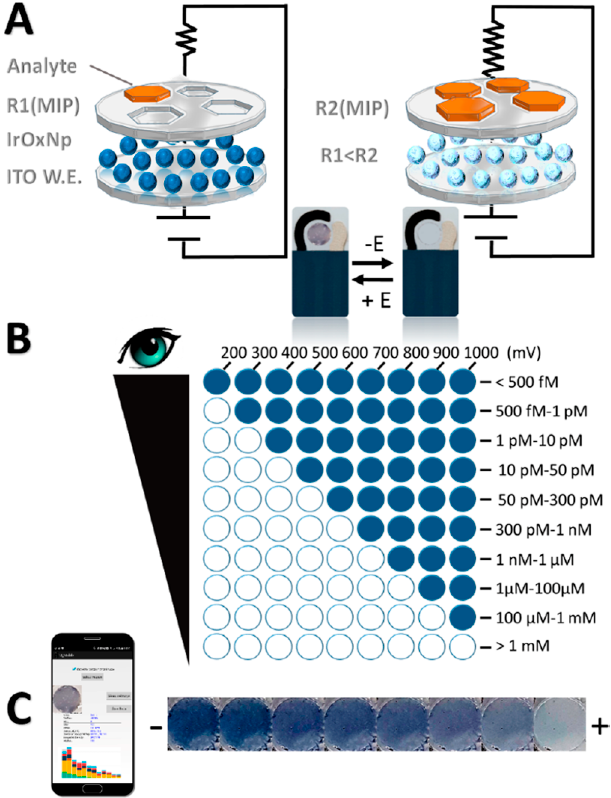
Figure 6. ( A ) Scheme of the MIP/IrOx NPs—ITO SPEs structure, visual IrOx NPs color change (from blue—black to transparent), and working principle of the proposed sensor with different amounts of analyte. ( B ) Visual detection after 10 s of the application of different oxidation potentials and concentration ranges detected based on the number of colored electrodes. ( C ) Change of the IrOxNPs’ color intensity at a fixed time and potential vs. increasing amounts of the analyte (smartphone-based detection). Reprinted from [37], with permission from American Chemical Society,